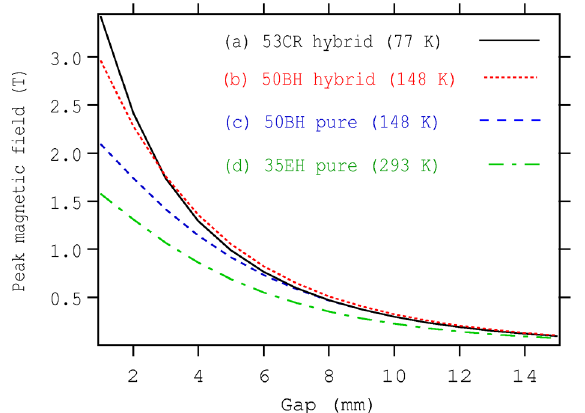
FIG. 6. (Color) K parameters of four different undulators at the gaps of 3 mm (solid lines) and 5 mm (dotted lines). ( a ) 53CR (cid:5) Dy hybrid CPMU (77 K); ( b ) 50BH (cid:5) permendur hybrid CPMU (148 K); ( c ) 50BH pure magnet CPMU (148 K); ( d ) conventional 35EH pure magnet undulator (room tempera- ture). K parameters are calculated according to Eq.